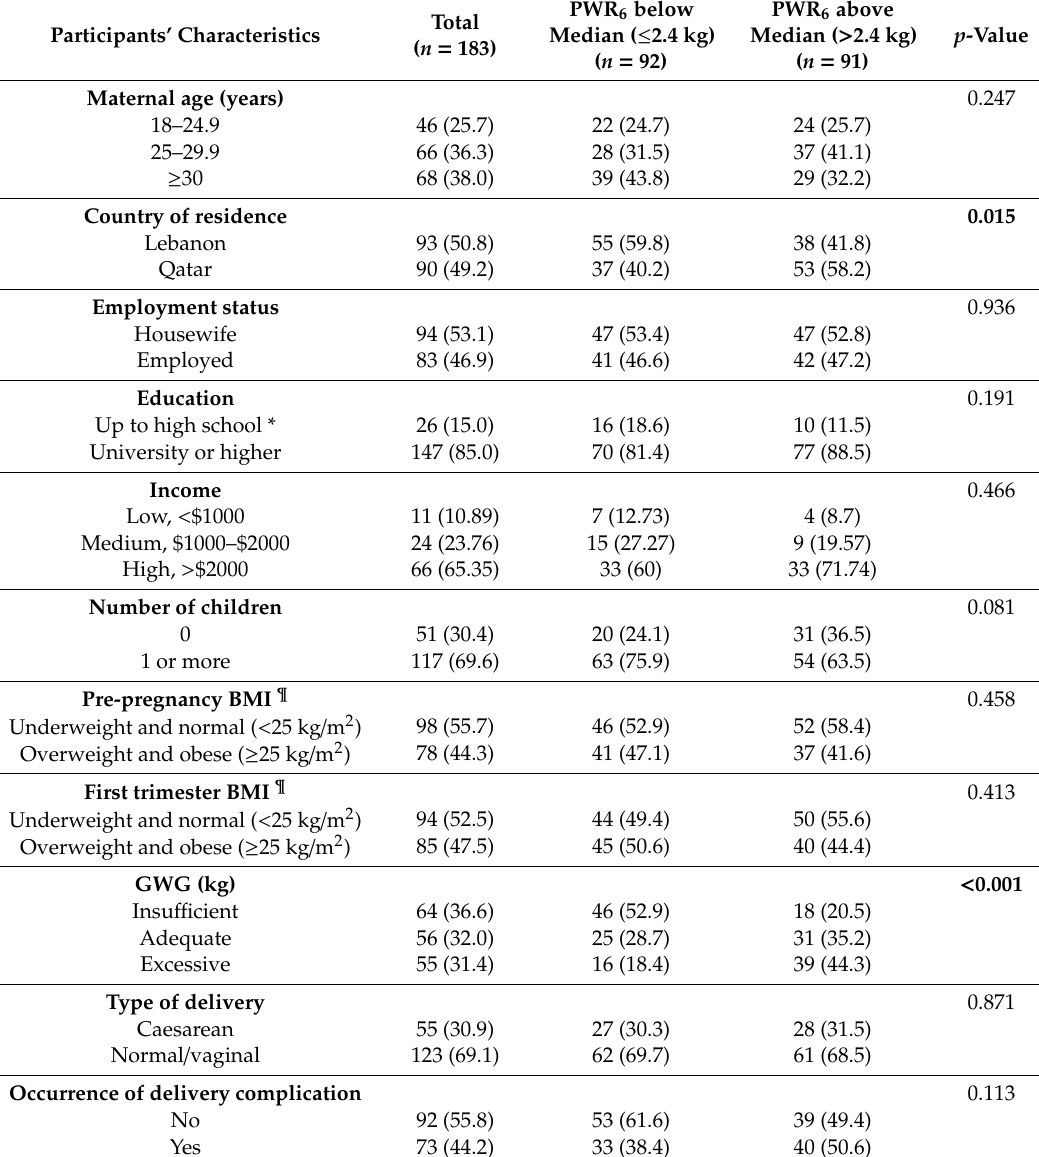
Table 1. Sociodemographic and lifestyle characteristics of study participants stratified by PWR 6 (below and above median